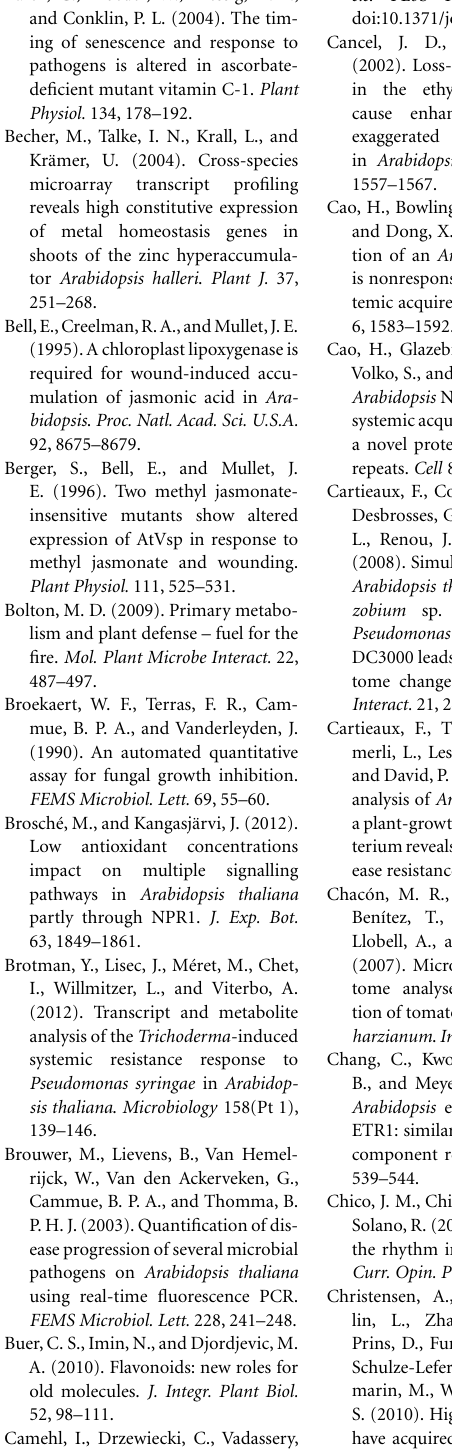
Figueroa-Balderas, R. E., García-Ponce,